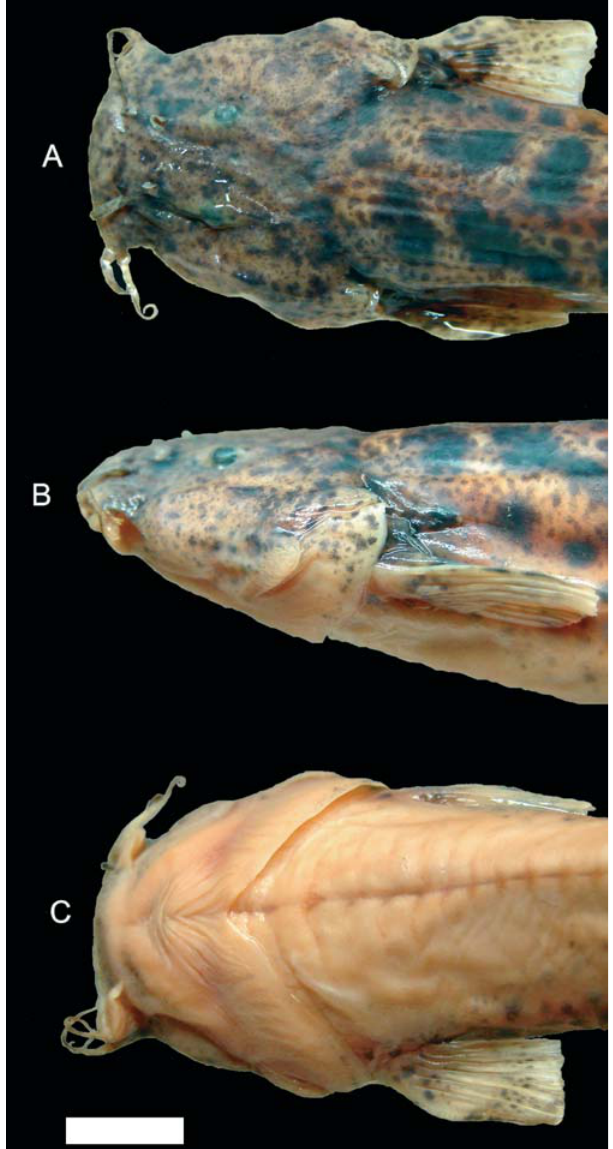
Fig. 2. Head of Trichomycterus igobi , MPEG 13352, holo- type, 90.1 mm SL: A) Dorsal view; B) Lateral view; C) Ventral view. Scale bar = 1